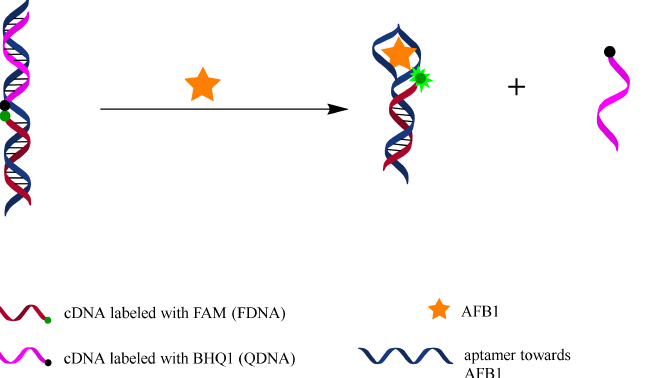
Figure 1. Working principle of fluorescent switch aptasensor for AFB1 detection. In the absence of AFB1, aptamer hybridizes with both FDNA and QDNA to form a tripartite DNA duplex structure in which FAM and BHQ1 are close to each other, causing fluorescence quenching. In the presence of AFB1, aptamer prefers to bind with AFB1 rather than QDNA, resulting in disassembly of the tripartite DNA duplex and fluorescence recovery. AFB1 can be detected by measuring the fluorescence